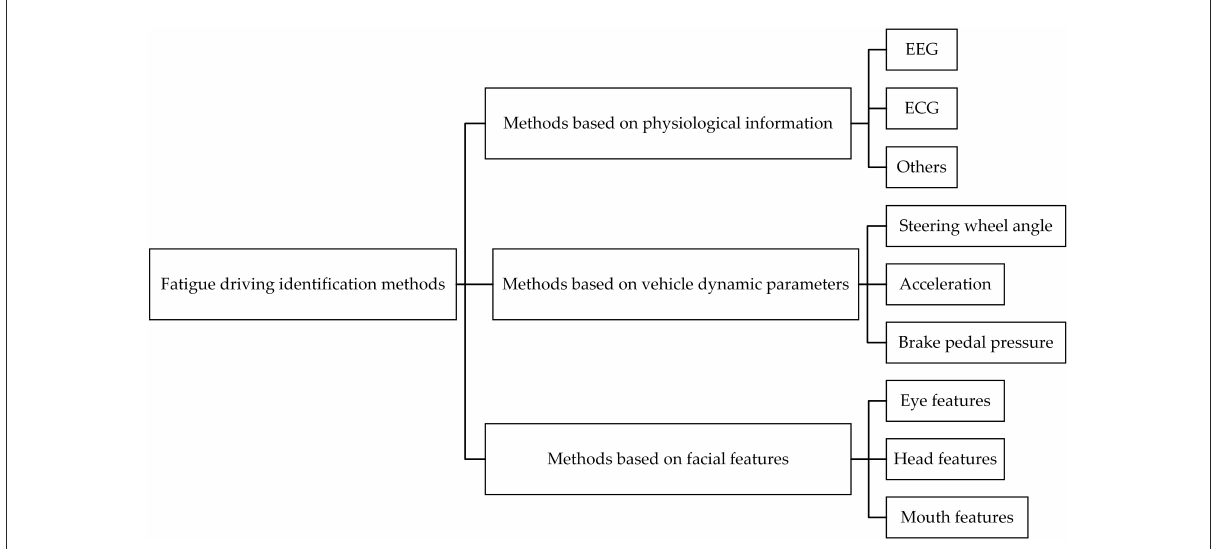
FIGURE1 The classification of the fatigue driving identification methods.